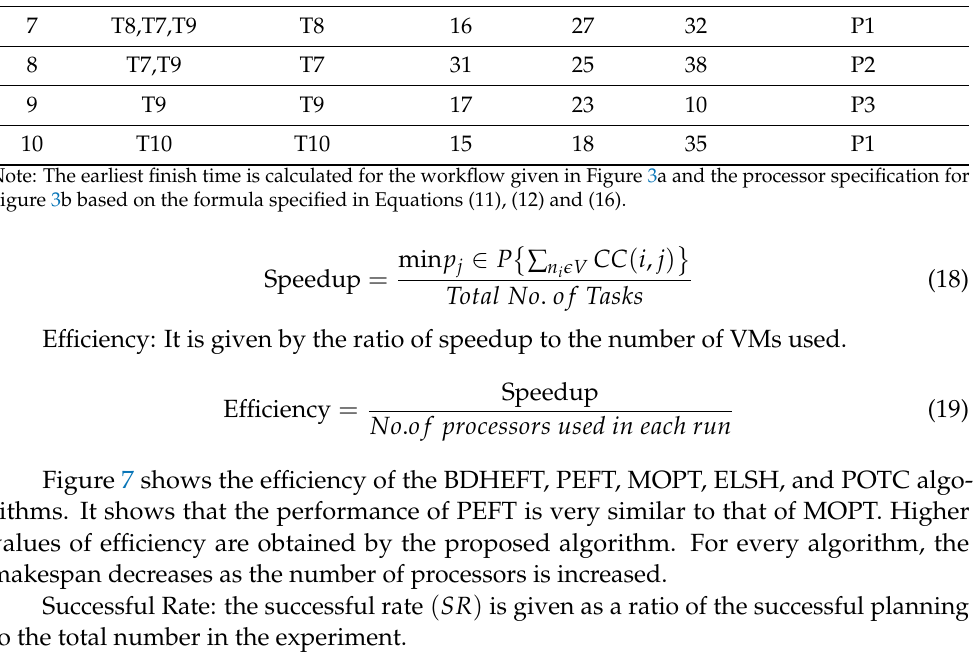
Table 2. Selection of task and processor in each iteration of the algorithm.